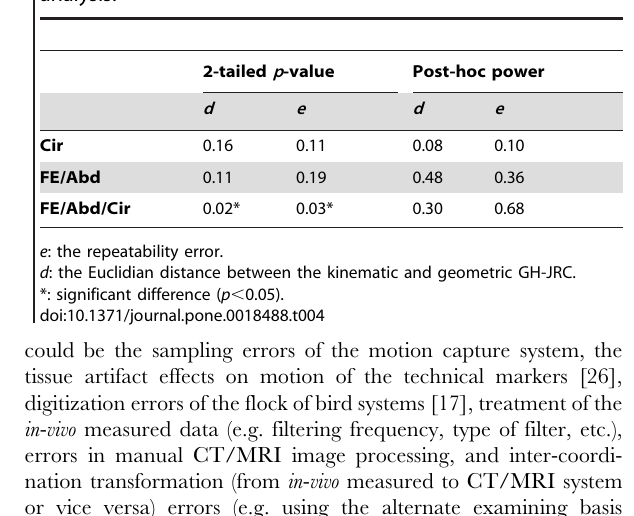
Table 4. The results of the paired t-Test and post-hoc power